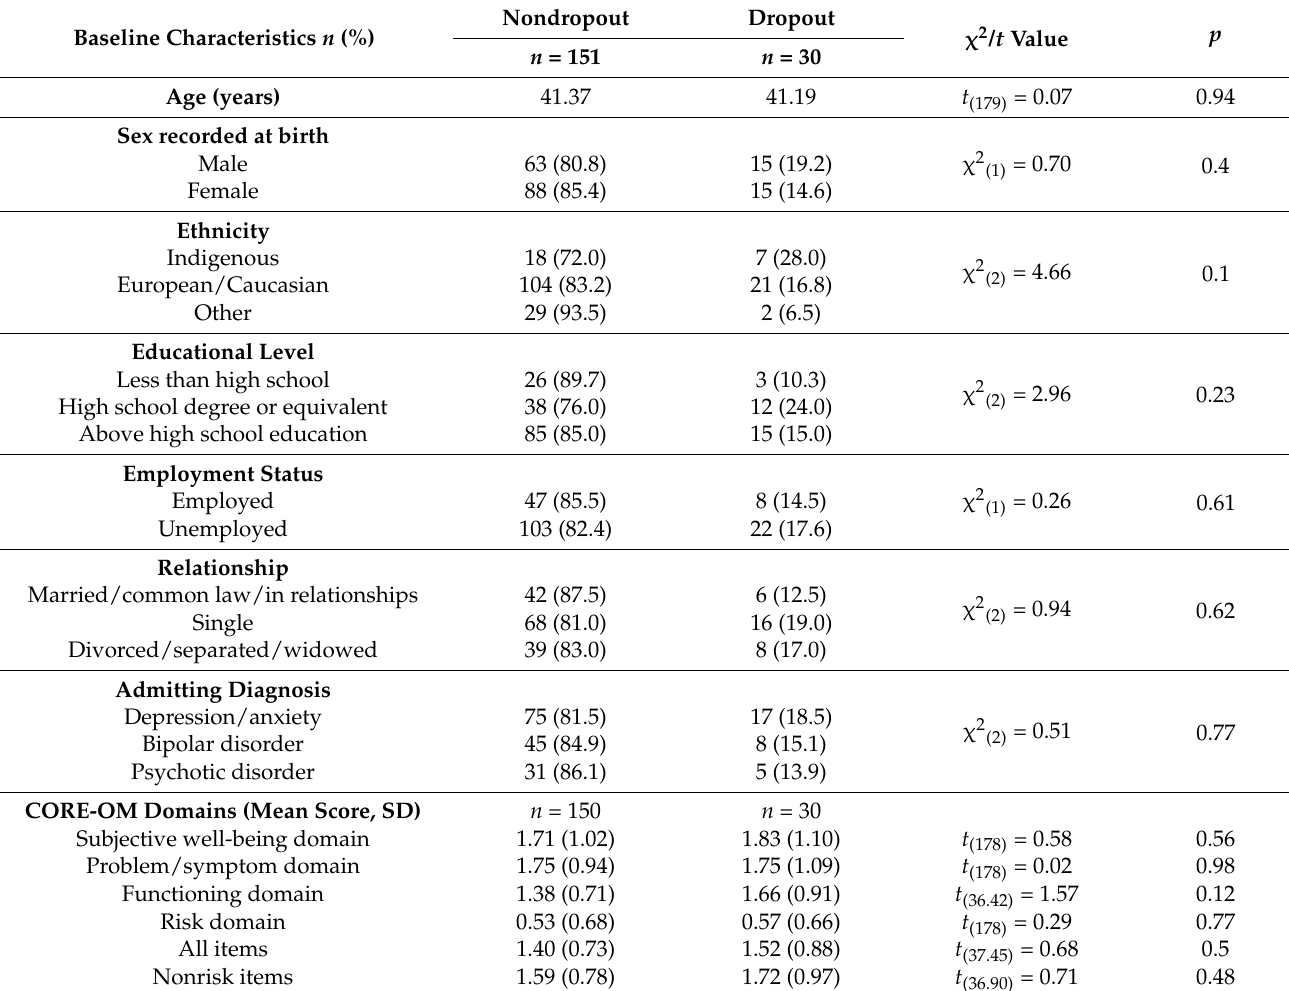
Table 1. Comparison between dropout and nondropout participants regarding baseline demographic and clinical characteristics and baseline CORE-OM domain